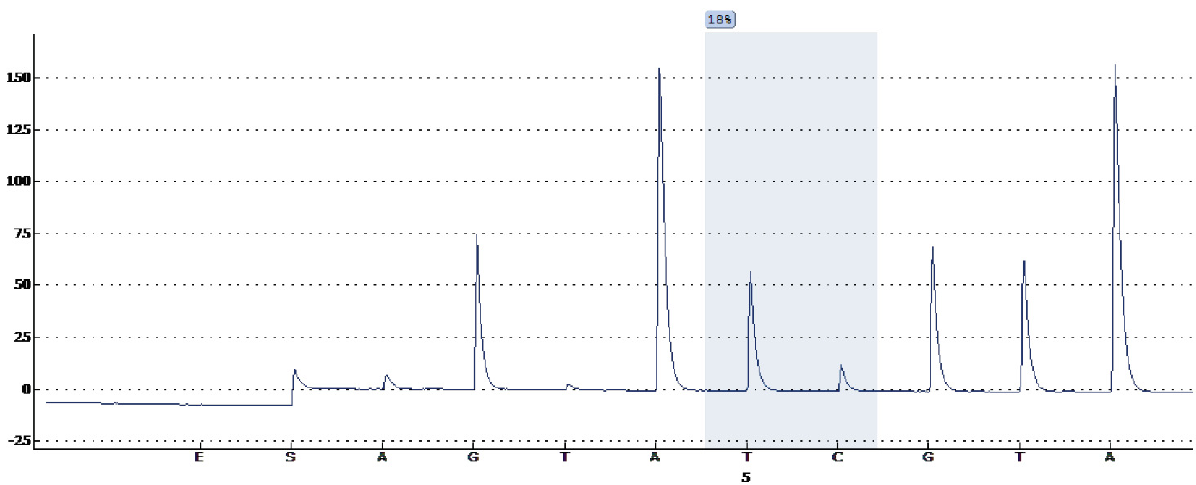
Figure 2. Only one methylation site was identified using pyrosequencing for target-specific sequencing at cg22436411 in the FCGR2B promoter region.